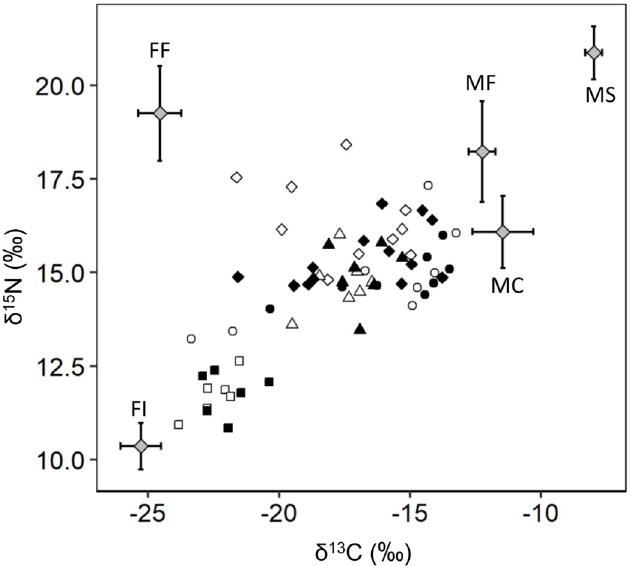
Fig 2. δ 13 C and δ 15 N values of Black-faced Spoonbill chicks and potential prey groups for diet reconstruction. The δ 13 C and δ 15 N values of the tip (early chick-rearing period; white) and middle (late chick-rearing period; black) portions of the primary feathers of Black-faced Spoonbill chicks at four breeding colonies: Gujido (square), Suhaam (circle), Namdongji (triangle), and Chilsando (diamond). Three individuals in the early chick-rearing period in Chilsando without δ 15 N values are not shown. Isotopic values of the five potential prey groups, corrected using the fractionation factor (71), are presented as gray diamonds: FF: freshwater fish, FI: freshwater invertebrate, MF: marine fish, MS: marine shrimp, and MC: marine crustacean.